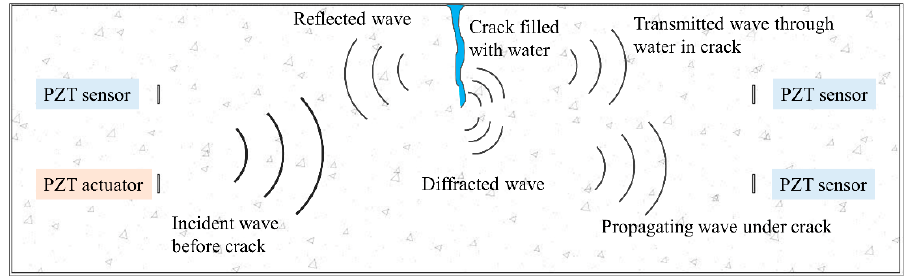
Figure 2. Schematic of stress waves propagating through a cracked concrete beam.